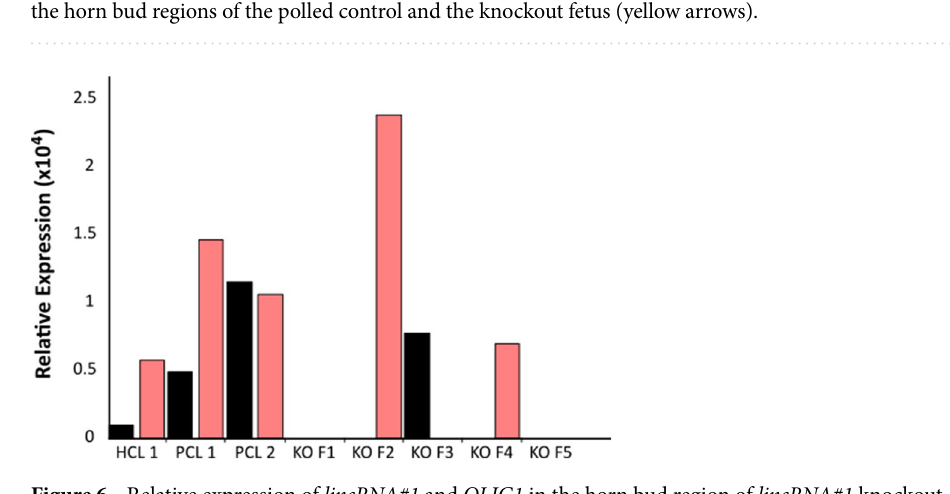
Figure 6. Relative expression of lincRNA#1 and OLIG1 in the horn bud region of lincRNA#1 knockout fetuses (KO F1-5), and one horned (HCL1) and two polled (PCL1 & PCL2) age matched controls. lincRNA#1 (black) and OLIG1 (salmon) were normalized relative to three reference genes ( GAPDH , RPLP0 and HPRT1 ). lincRNA#1 KO genotypes are as follows: mosaic KO (F1), biallelic KO (F2), mosaic KO (F3), biallelic KO (F4) and biallelic KO